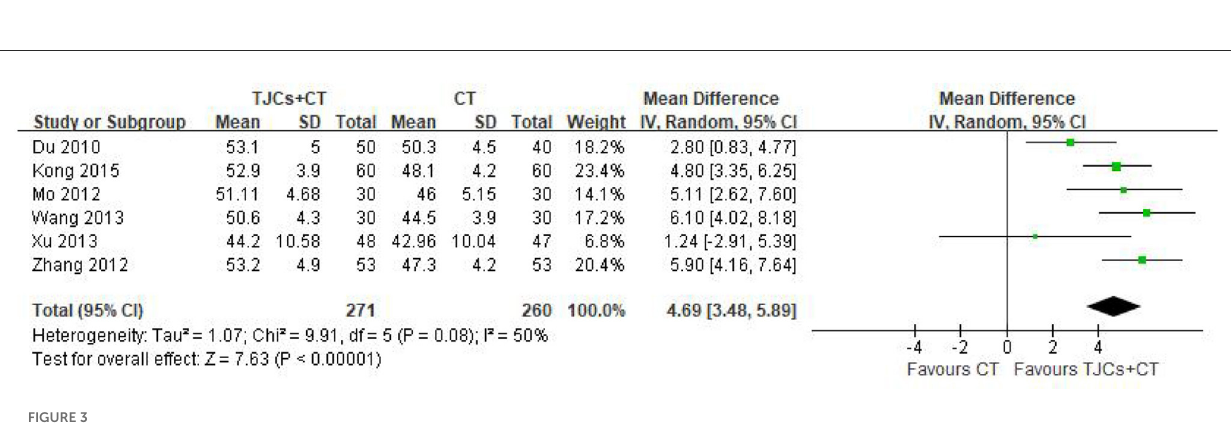
FIGURE3 Forest plot of Median nerve MNCV